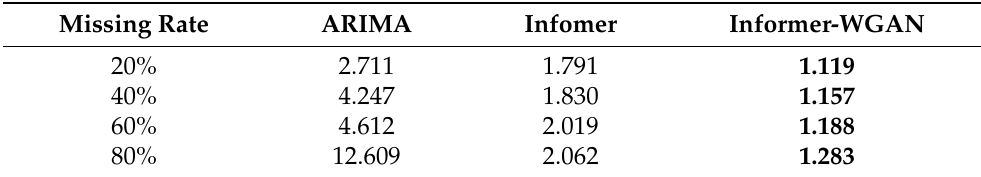
results on electricity dataset.